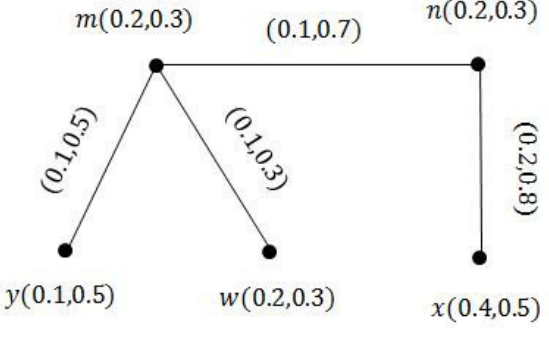
Figure 8. Irregular Vague Graph (IVG)( G